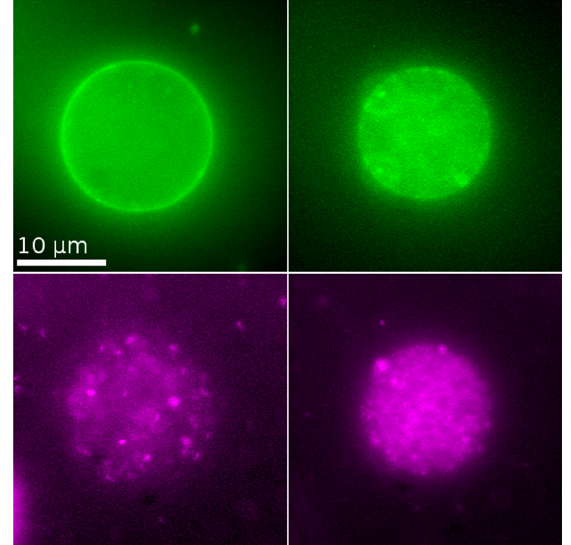
Figure 3: 1,2-dioleoyl- sn -glycero-3-phosphocholine (DOPC) vesicle (green), 1 min (left) and 10 min (right) after the incubation with nanoparticles ( r = 42 nm, magenta). Obviously, vesicle membrane is consumed while particles are internalized. During the uptake process, the vesicle radius, i.e., the mem- membrane label. They diffuse freely inside the vesicle mem- brane. This indicates that the particles are engulfed by the mem-